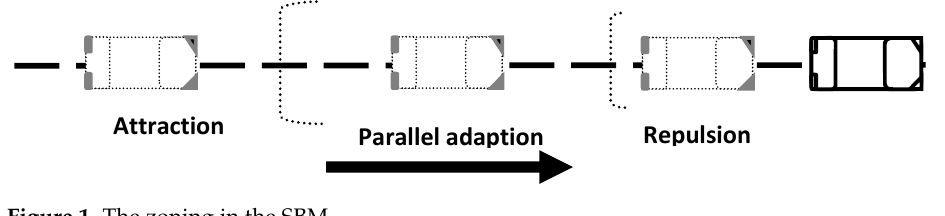
Figure 1. The zoning in the SBM.